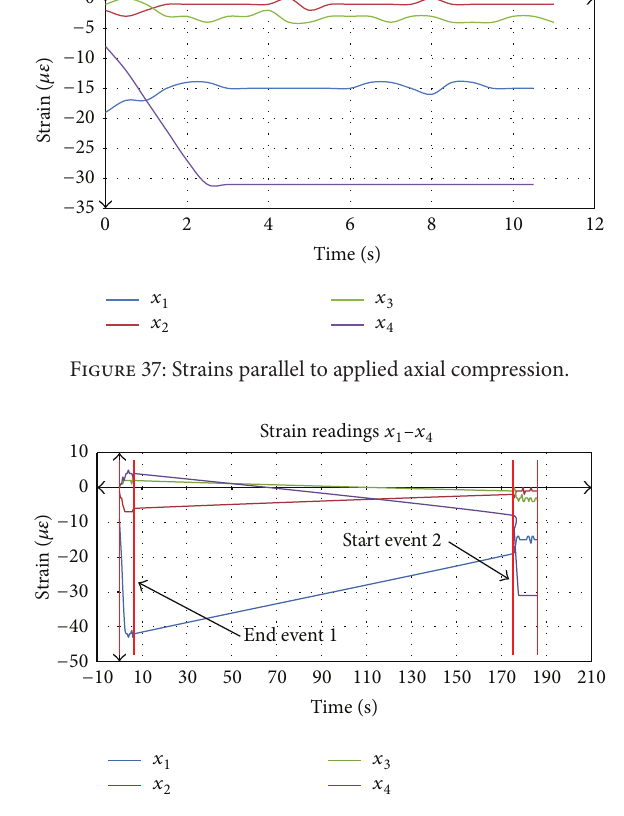
Figure 38: Strain reading 𝑥 1 to 𝑥 4 —end Event 1 to start Event 2.